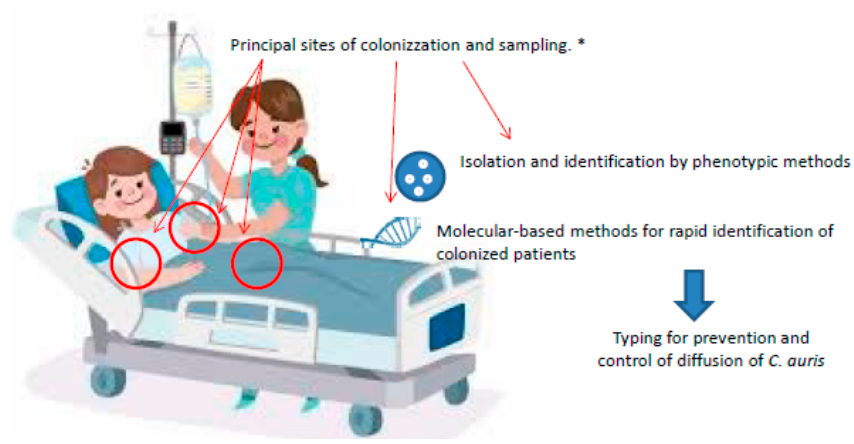
Figure 1. Screen, detect, test and control for control of di ff usion of C. auris. * For patients with a strong hypothesis of C. auris infection, in the case of negative screens, sampling should be repeated within seven days and before discontinuing any infection prevention and control